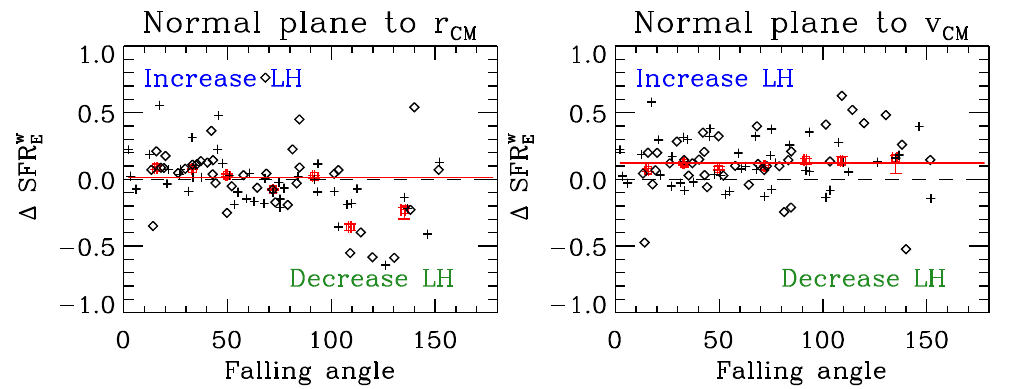
Figure 2. SFR differences between the leading and trailing halves of the galaxy as a function of the falling angle. Left panel shows the results halving the galaxy in the plane perpendicular to the position of its centre of mass ( observational case ), while the Right panel shows the differences halving the galaxy in the plane perpendicular to the velocity vector of its centre of mass, relative to the BCG ( simulation case ). Diamonds indicate the galaxies residing on relax clusters, while the crosses show the galaxies of less relaxed systems. The errors correspond to the one sigma percentiles of each bin divided by the number of galaxies of each bin. The red line shows the median of all